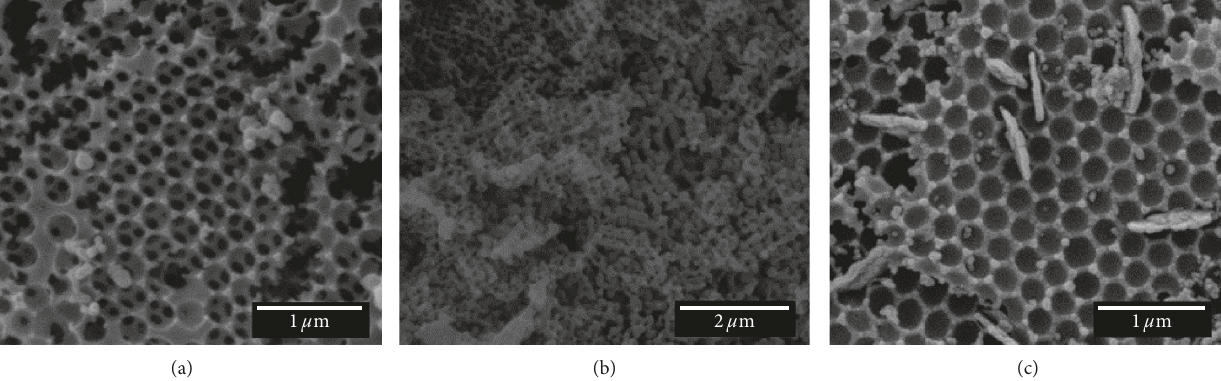
Figure 2: SEM images of 3DOM CaO/Al ( ×